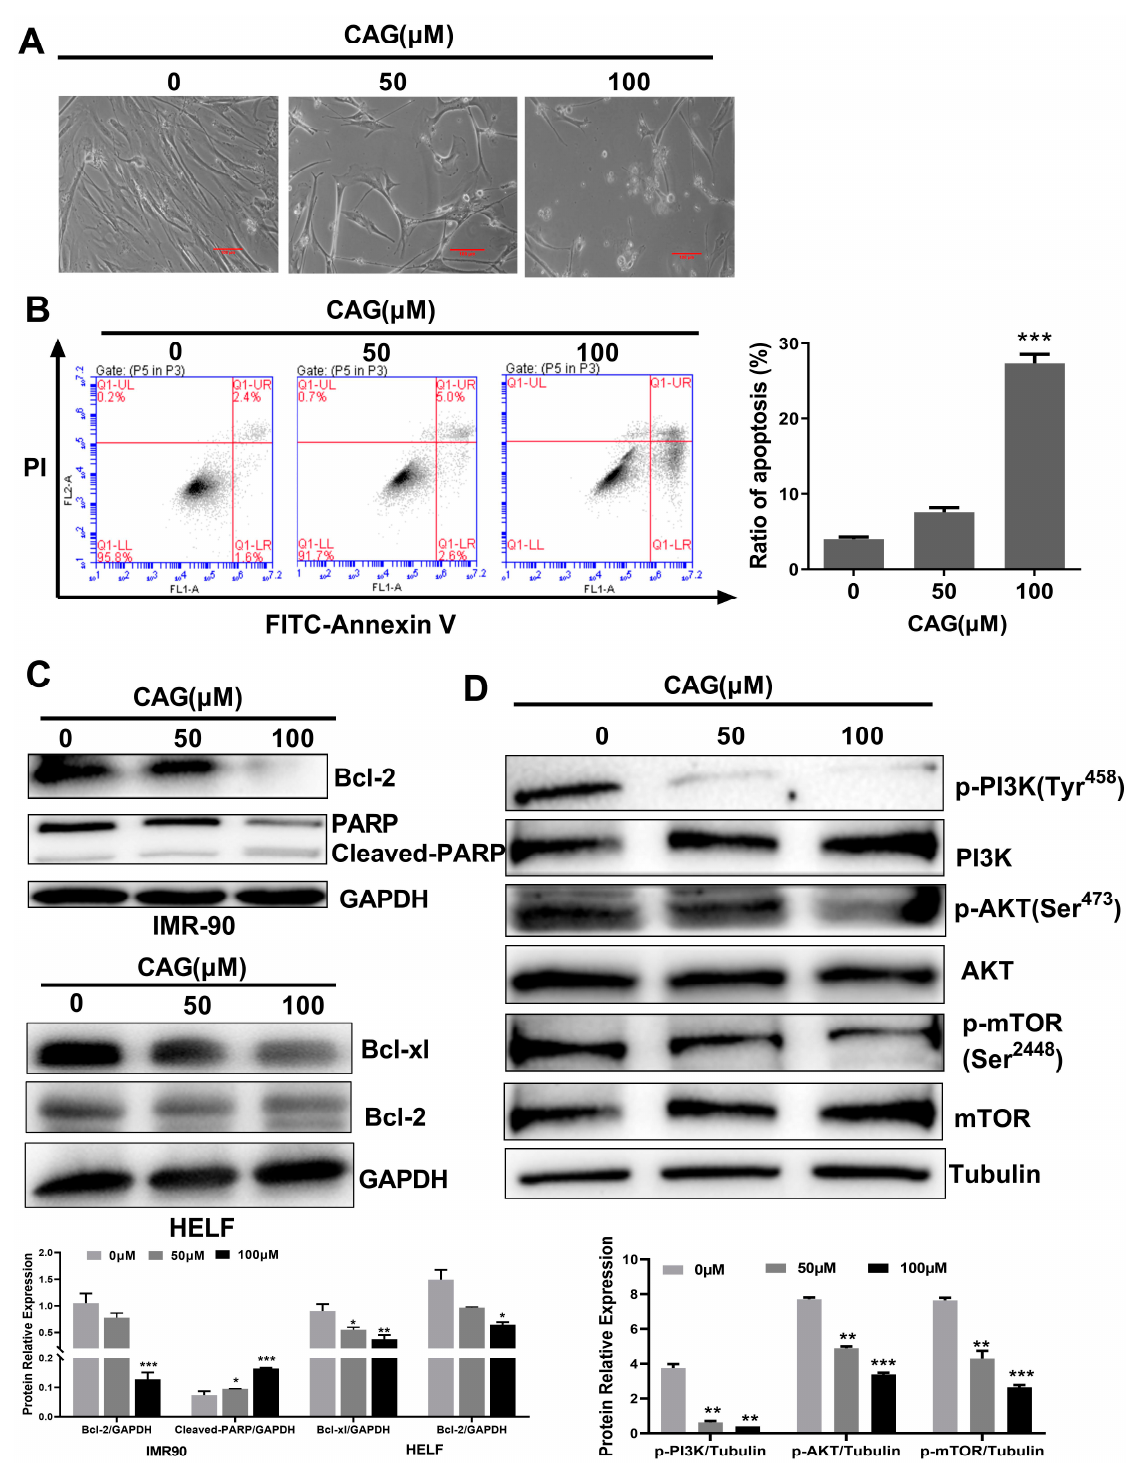
Figure 2. CAG induces SCs apoptosis by inhibiting the antiapoptotic Bcl-2 family and PI3K/AKT/mTOR pathway. ( A ) Cell morphological changes in SCs after CAG treatment. Mi- croscopic (magnification of 200 × ) images were taken. ( B ) Flow cytometric analysis of the cell death of SCs treated with CAG via annexin V/PI staining. ( C , D ) The expression levels of Bcl-2, PARP, Bcl-xl, and PI3K/AKT/mTOR pathway in SCs after incubation with indicated concentrations of CAG. Protein levels were determined using Western blots. The value represents the protein expressions compared to the GAPDH or Tubulin. * p < 0.05, ** p < 0.01, and *** p <